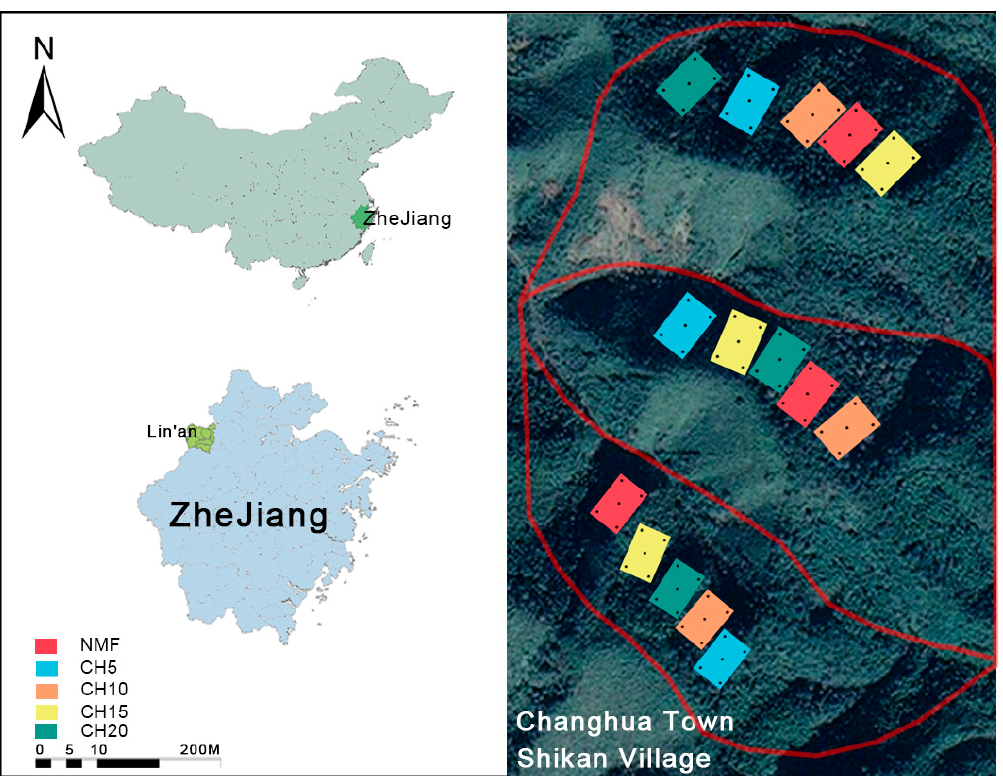
Figure 1. Study area with the experimental plot layout. NMF: Chinese hickory–broad-leaved mixed forest; CH5, CH10, CH15, CH20: monospecific Chinese hickory stands with 5, 10, 15, and 20 years of intensive management, respectively.